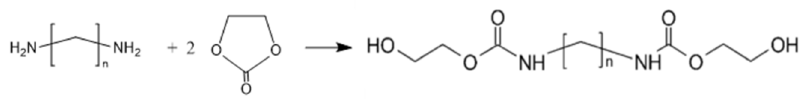
Figure 1. The reaction of MF resin with polyols